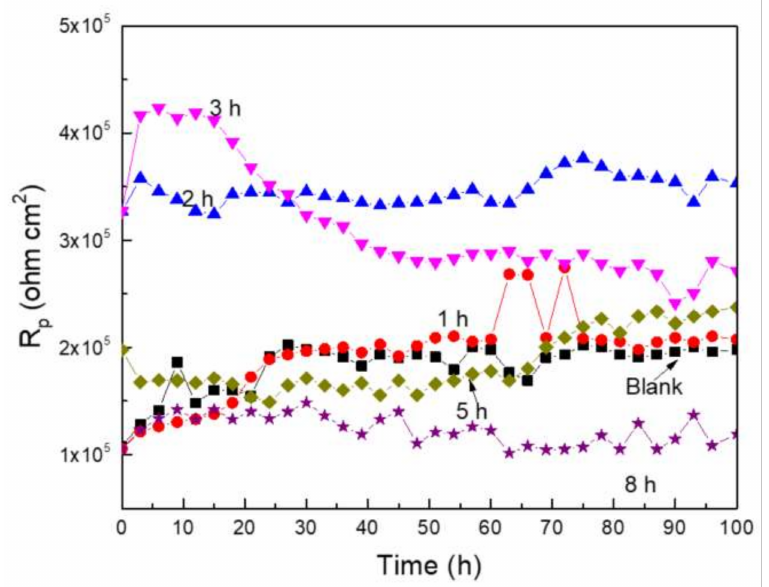
Figure 5. Effect of the oxidizing time on the R p value for Ti6Al4V alloy corroded in artificial saliva